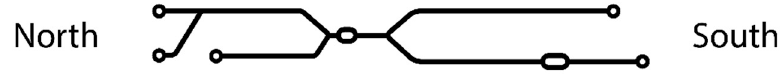
Figure 1. Schematic layout of the commuter train network in Stockholm.